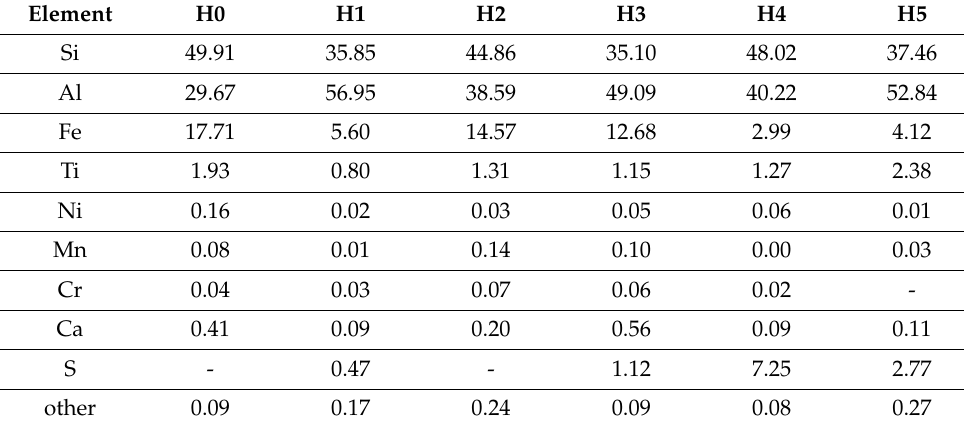
Table 4. The chemical composition of halloysite raw and modified samples measured by the XRF method. Values present the percentage of particular elements in the analyzed sample. Samples, treatment details, and names are described in Table 2.